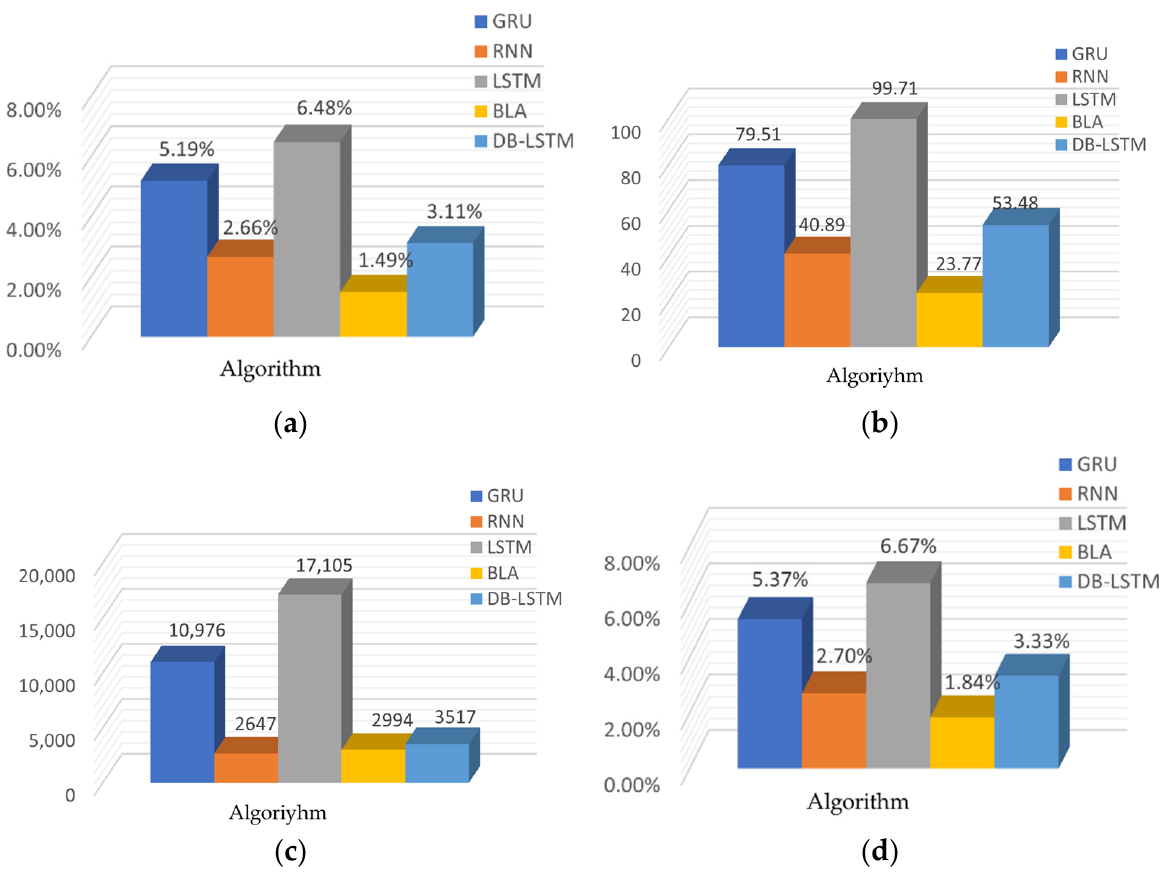
Figure 10. Performance comparison chart of different algorithms. ( a ) MAPE comparison . ( b ) MAE comparison . ( c ) MSE comparison . ( d ) SMAPE comparison .